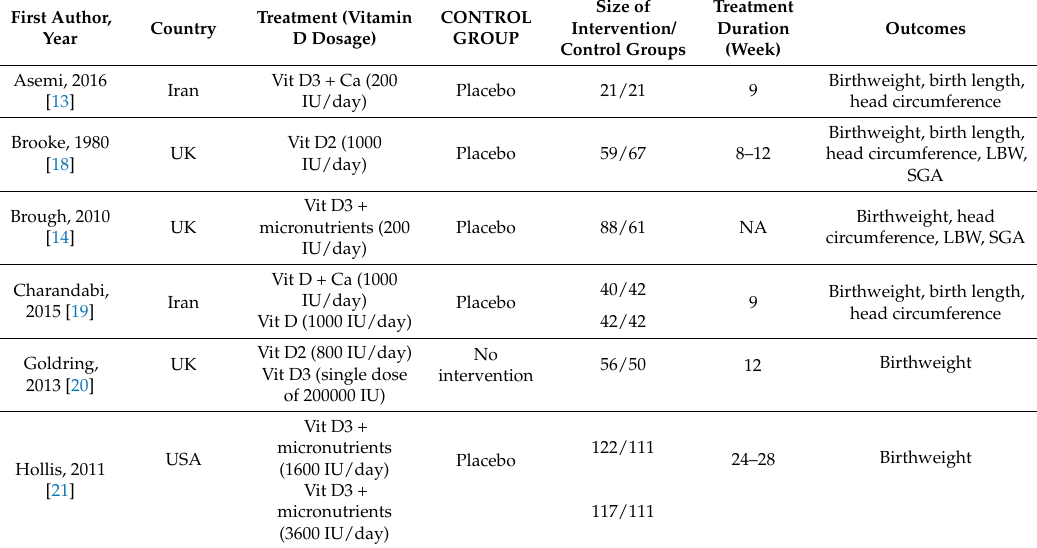
Figure 1. PRISMA flow diagram of study selection. Table 1. Characteristics of randomized controlled trials included in the meta-analysis.